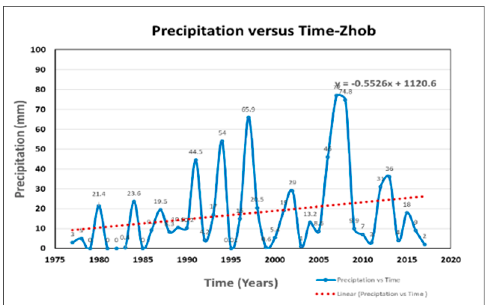
Figure A2. Graphs showing the precipitation decrements for each station as functions of time for January. Graphs showing the precipitation decrements for each station as functions of time for June. The precipitation graphs for each station (as functions of time) for January and June are shown in Appendix E. The trend equations are also shown on each graph. One can see that the decrement (increment) trend slopes for January and June, for which the MK and TS report significant trends (i.e., p -value < 5%), are much higher than for the other months.